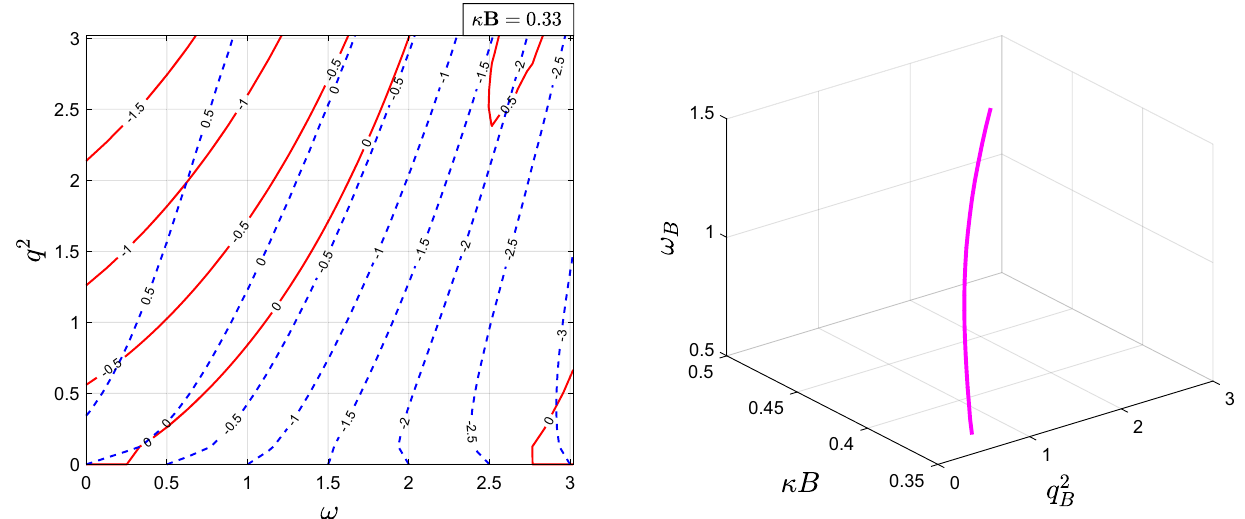
Fig. 21 Contour plots for the functions φ R (blue dashed) and φ I (red solid) at κ B = 0 . 33 (left); continuum of discrete non-dissipative modes ( ω B , q B ) as function of κ B (right)